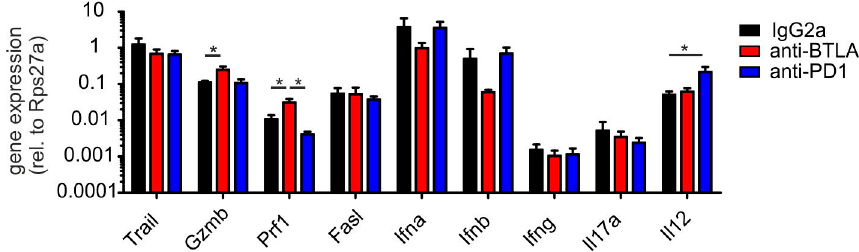
Figure 4. Anti-BTLA antibodies induce cytotoxic lymphocyte marker expression. PyMT tumors were treated with 5 mg/kg of each anti-BTLA, anti-PD-1 or isotype control (IgG2A) antibodies ( n = 7 each) twice weekly for three weeks once the first tumor reached a size of 0.5 cm in diameter. Tumors were harvested for quantitative PCR analysis 21 days after initial treatment. The expression of the indicated genes relative to the house-keeping gene Rps27a is displayed. p -values were calculated using one-way ANOVA with Bonferroni’s correction, * p < 0.05.